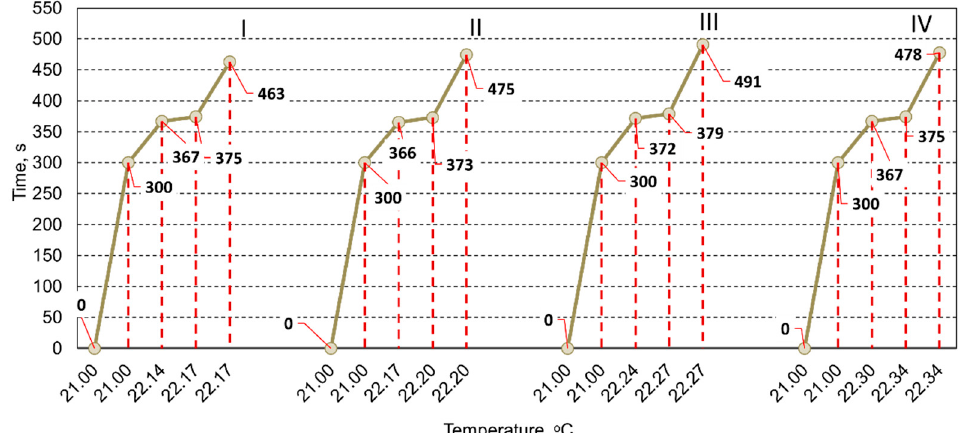
Figure 11. Time characteristics of the individual combustion stages of a sample of spruce trees conditioned with a pulsed electric field: I (electric field intensity 25 kV · cm − 1 and number of pulses 150); II (electric field intensity 25 kV · cm − 1 and number of pulses 300); III (electric field intensity 30 kV · cm − 1 and number of pulses 150); IV (electric field intensity 30 kV · cm − 1 and number of pulses 300). It was found that the longest times from ignition to reaching the maximum temperature were obtained for the material under the influence of PEF with an electric field intensity of 30 kV · cm − 1 and the number of pulses 150 (III combination), while the shortest time of the analyzed interval was stated for the second combination of the experiment (electric field intensity 25 kV · cm − 1 and number pulses 300). Taking into consideration all the used combinations of experiments, from the point of view of the duration of individual combustion cycles, there were no statistically significant differences in the measured values. Only a slight increase in the value of time was found for the samples after the PEF exposure, where the discharge electric field intensity amounted to 30 kV · cm − 1 . It should be underlined that in the case of the first combination, the combustion time is the shortest in all measured sections.